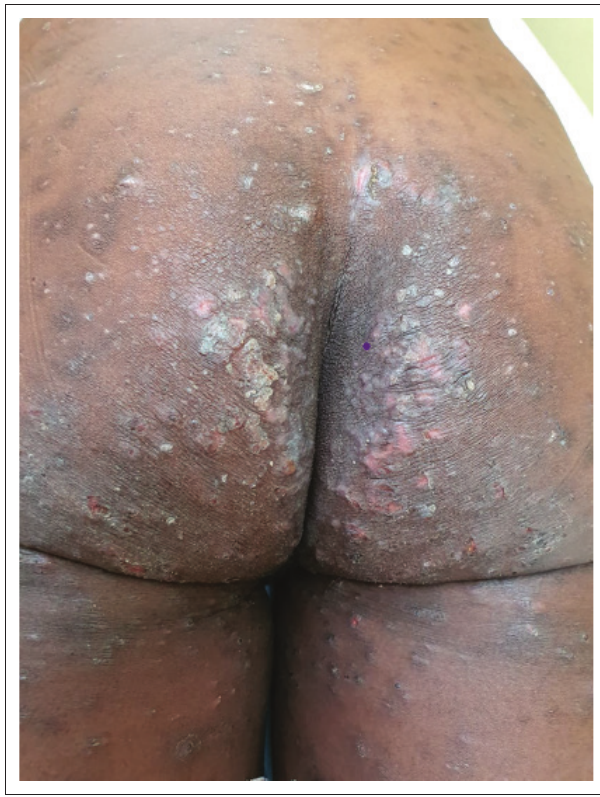
FIGURE 2: Eczematisation of scabies on thighs, buttocks and intergluteal cleft. Note the excoriations and